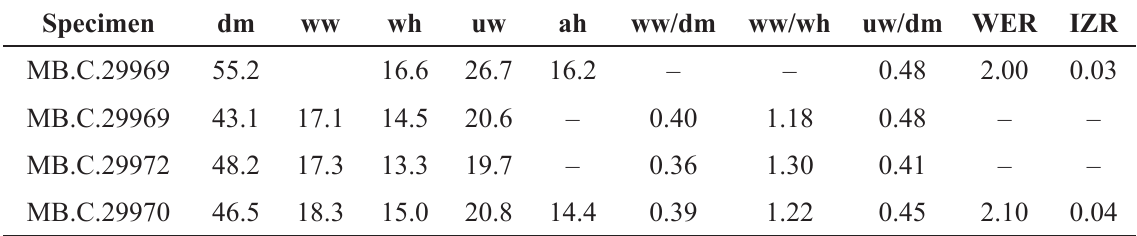
Table 23. Conch dimensions (partly estimated) and ratios of selected specimens of Alibashites mojsisovicsi (Stoyanow, 1910) from Baghuk